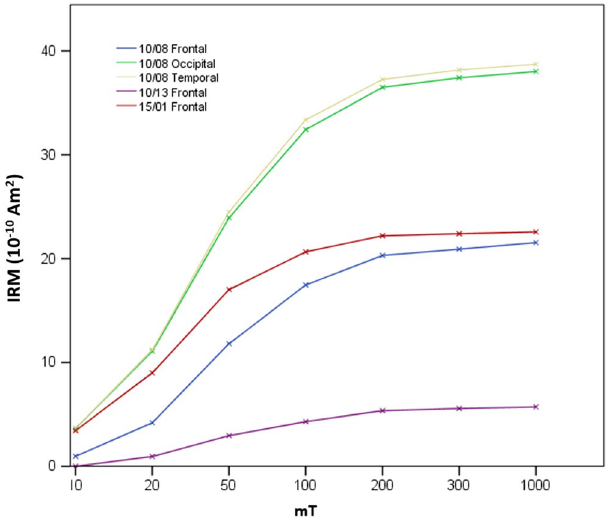
Figure 1. Room-temperature IRM acquisition of human brain tissue, Manchester Brain Bank samples.